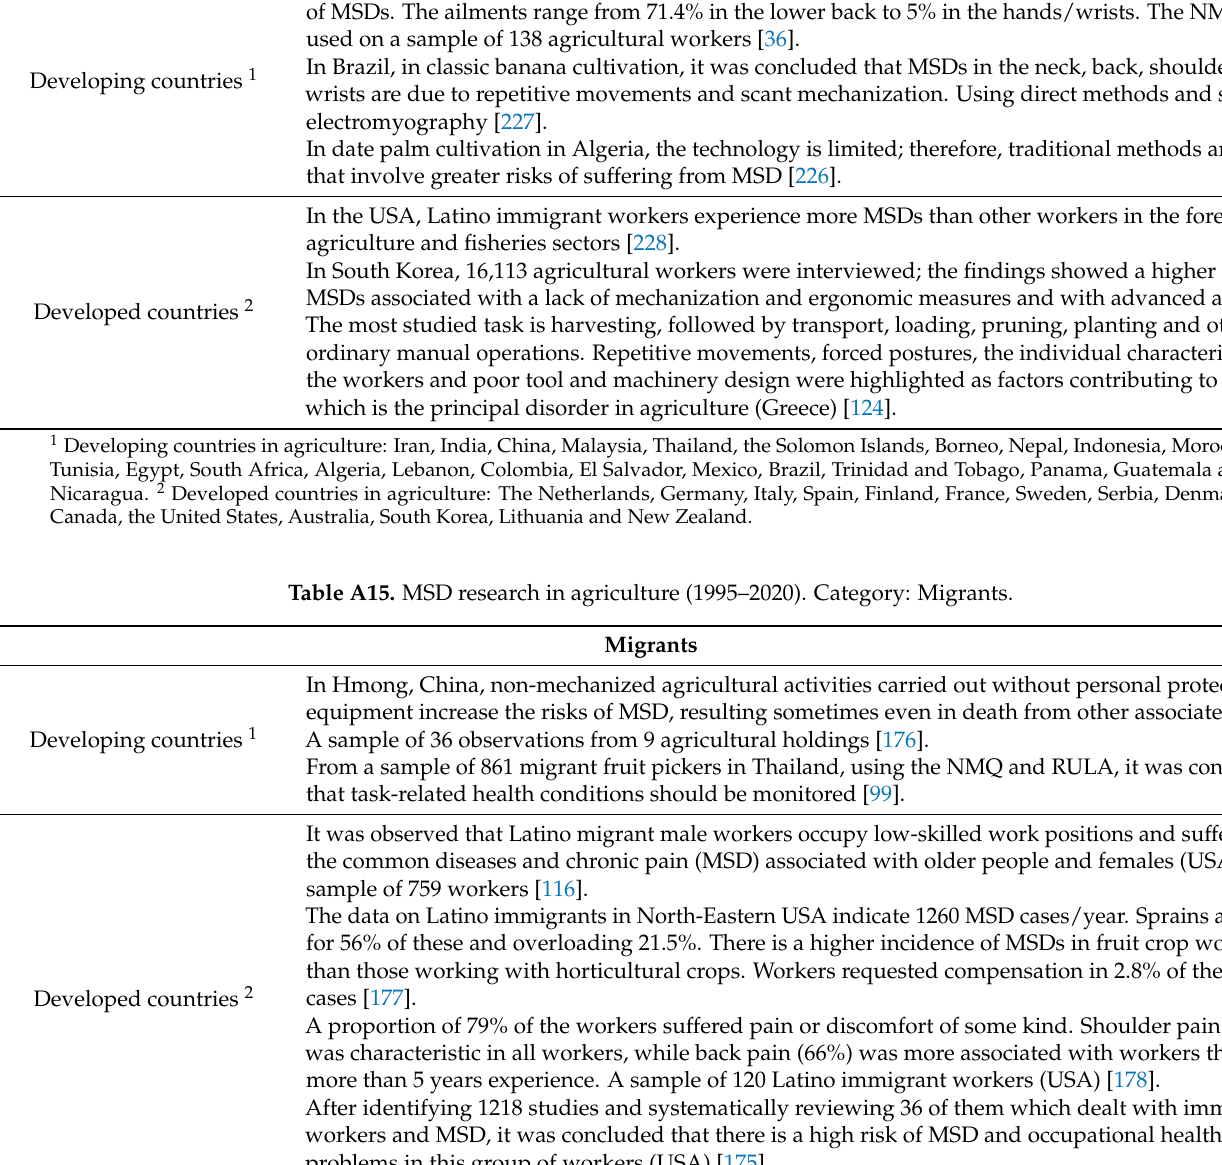
Developing countries 1